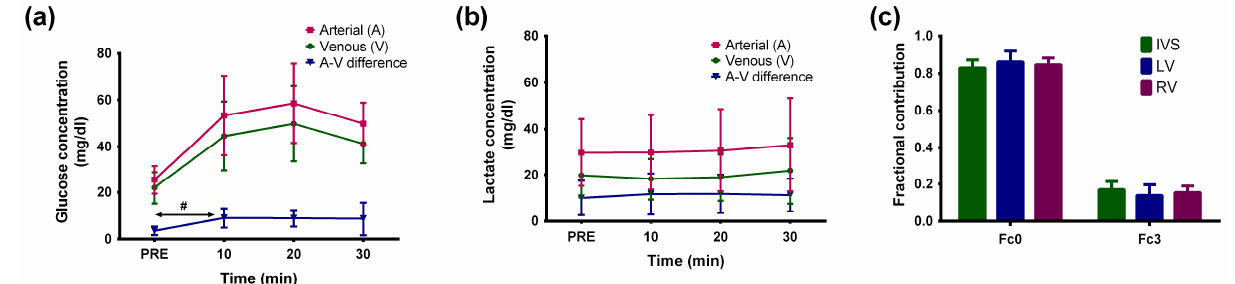
Figure 2. Arterial, venous, and arterial-venous (A-V) differences in ( a ) glucose and ( b ) lactate (right) concentrations prior to (PRE) and during the course of [U- 13 C] glucose infusion. Error bars are standard deviation ( n = 5; 2 males and 3 females). # indicates statistically significance (“PRE” vs. “10 min.”; p < 0.05; two–tailed Student’s t –test). Glucose and lactate concentrations were measured as described in Methods section. ( c ) Fractions of acetyl-CoA without 13 C enrichment (Fc0) and enriched at both carbons of the acetyl group (Fc3) estimated from 13 C NMR spectra (Figure 1).